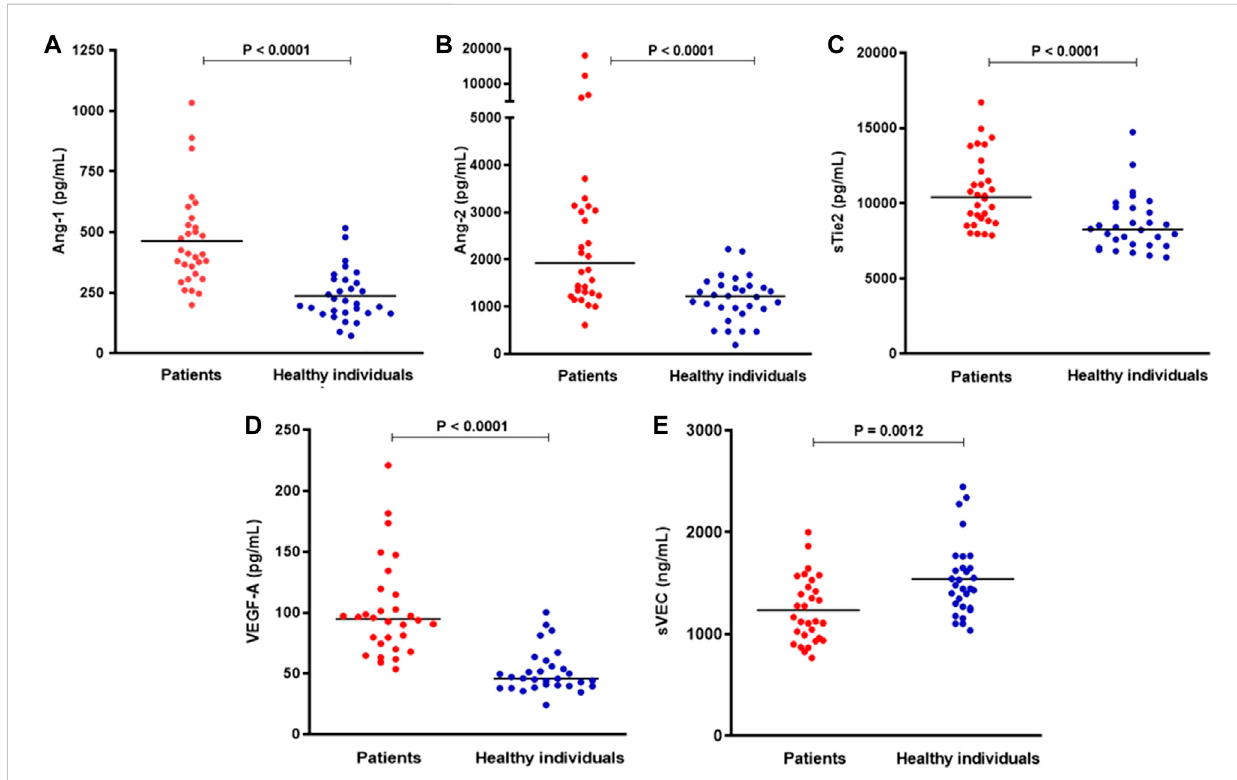
FIGURE 1 Plasma levels of (A) Ang-1, (B) Ang-2, (C) sTie2, (D) VEGF-A,and (E) sVEC inpatients with COVID-19and healthy individuals. Horizontal barsindicate median values, and p values are from Mann-Whitney test ( n = 28 – 30 per